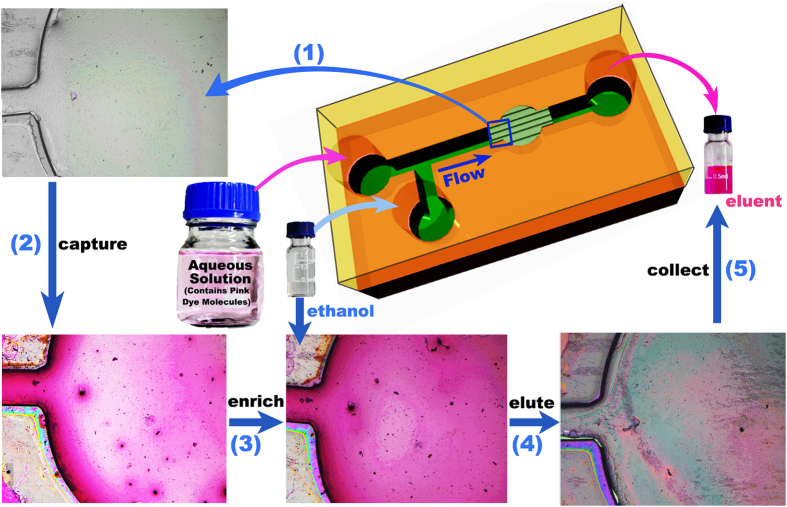
Experiment of acid-fuchsin pink dye concentrated and micro-extracted from water to ethanol, by using the nano-channel integrated micro-chip.The photograph of the glass bottle was taken by P.C.X.